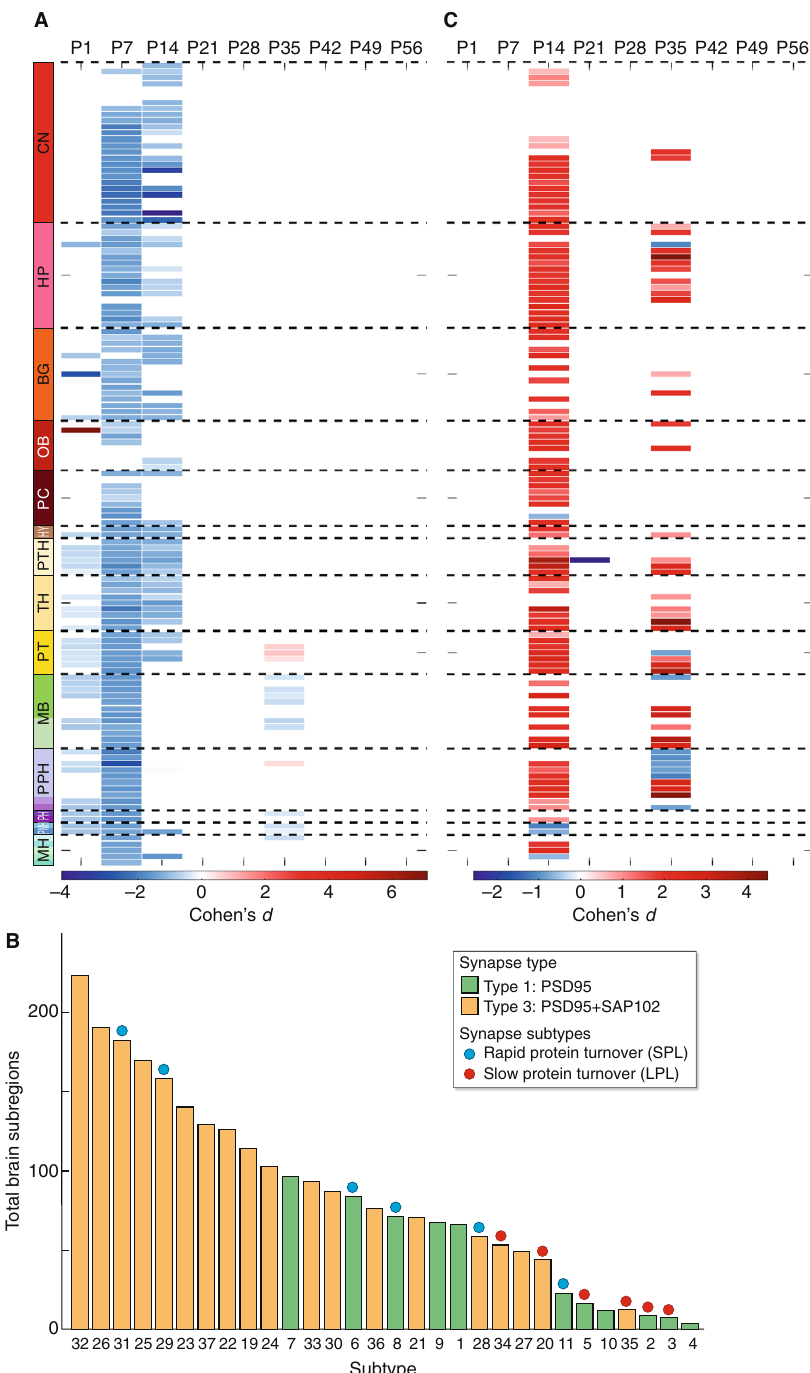
Fig. 4 | Synapse subtypes with rapid protein turnover are preferentially affected in the Pax6 +/ − brain. A Changes in synapse diversity in brain subregions between Pax6 +/ − andcontrolmiceforthedifferentagegroups.Scalebar(Cohen ’ s d ) indicates increase in red and decrease in blue ( P <0.05, Bayesian test with Benjamini – Hochberg correction) of synapse diversity in Pax6 +/ − brain subregions. Absence of color indicates subregions where no signi fi cant differences occurred. B RankingofPSD95-expressingsynapsesubtypesaccordingtothenumberofbrain regions affected in Pax6 +/ − mice. For each subtype the total number of